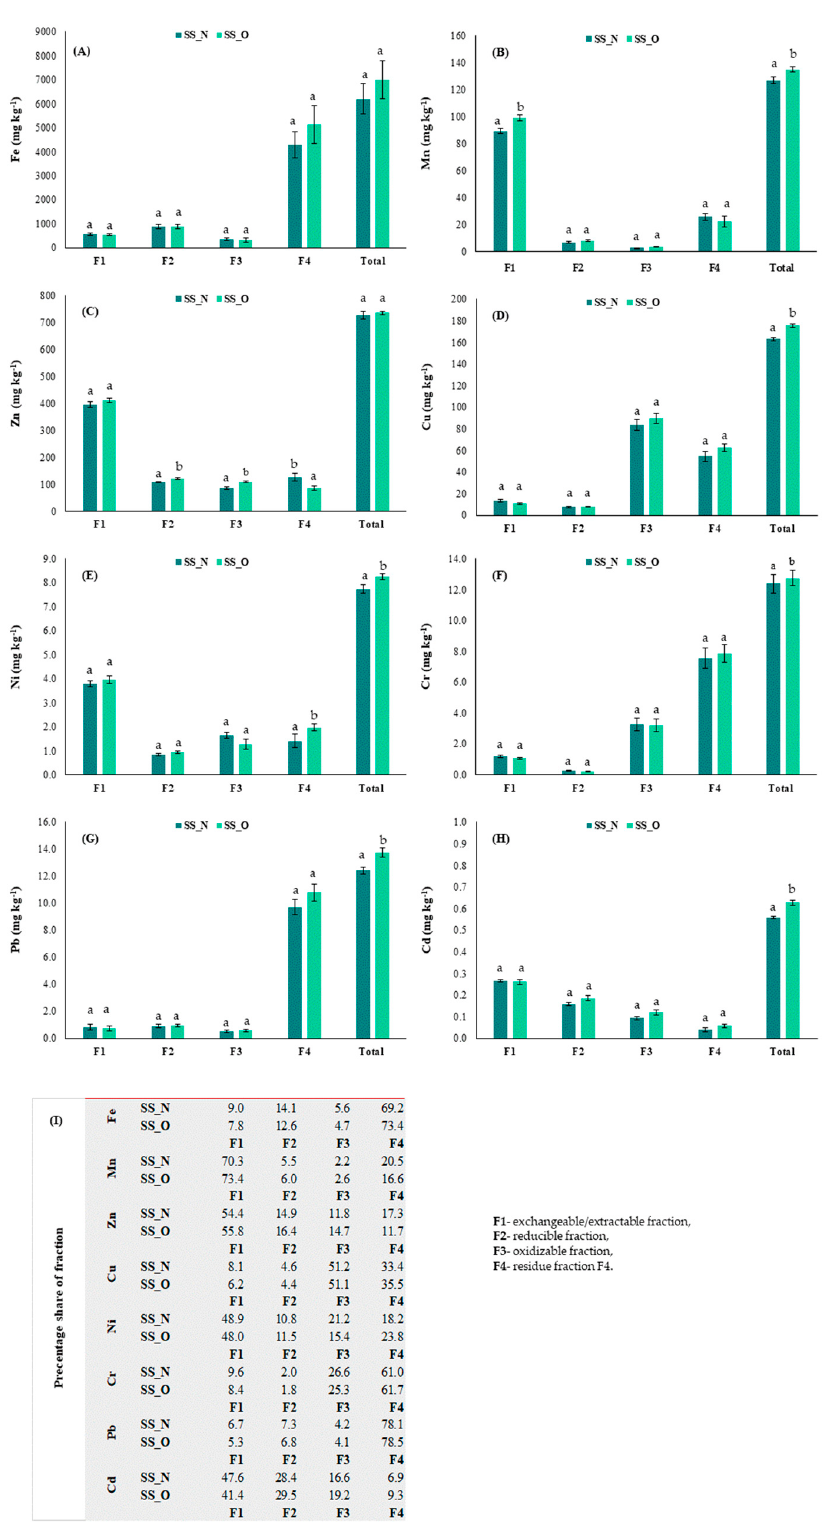
Figure 1. Total concentration and chemical speciation of trace elements Fe ( A ), Mn ( B ), Zn ( C ), Cu ( D ), Ni ( E ), Cr ( F ), Pb ( G ), Cd ( H ), and percentage share of individual fraction ( I ) in non-ozonated (SS_N) and ozonated (SS_O) sewage sludge. Mean values ( n = 18) ± standard error. Identical letters denote no significant ( p < 0.05) differences between the analyzed experimental variants according to the post hoc Tukey HSD test.